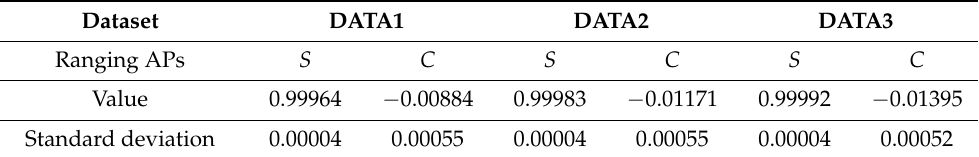
Table 18. Estimated ranging systematic parameters for the three datasets. Dataset